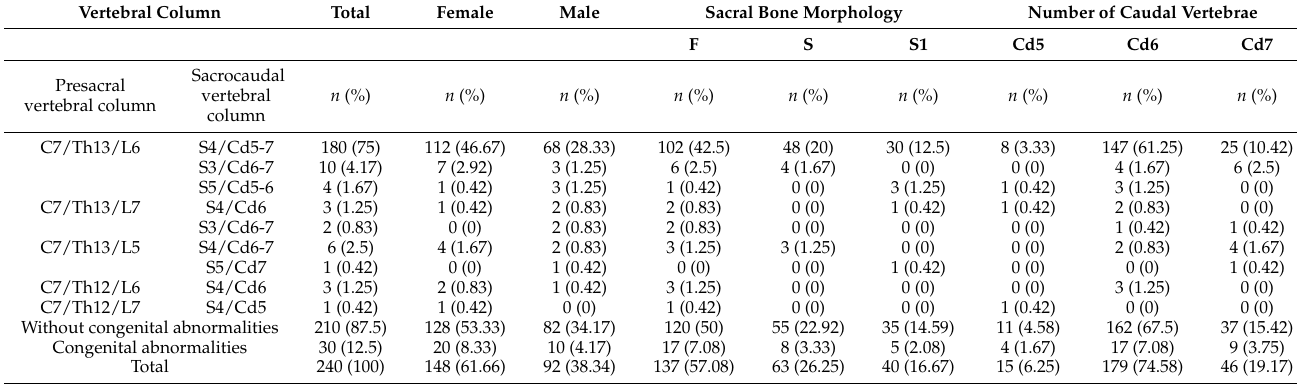
Table 1. Prevalence ( n , %) of different vertebral formulae of the vertebral column and morphologic variants of sacral bone. Vertebral Column